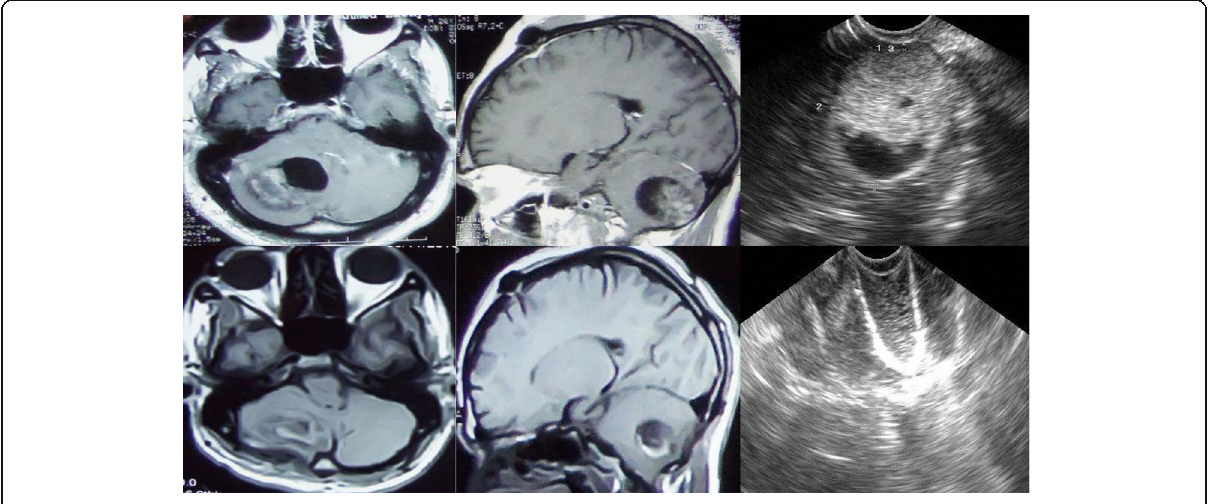
Fig. 2 Gross total resection of posterior fossa astrocytoma grade 3 in sitting position; preoperative and postoperative MRI T1 with contrast and IOUS images. NOTE; the elongated gel filled finger glove technique in last